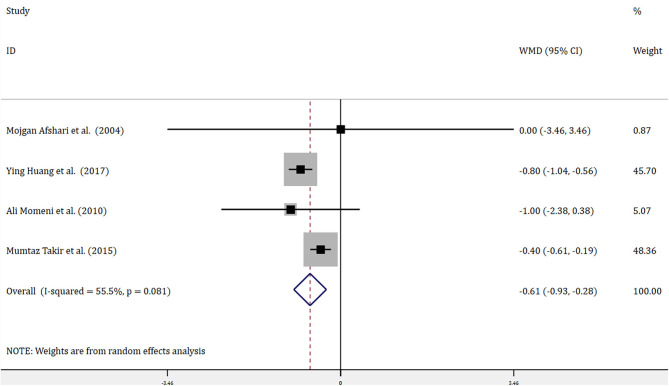
Forest plot of meta-analysis of the effect of ULT with allopurinol on FBG. Data are pooled WMDs with 95% CIs. ULT, uric acid-lowering therapy; FBG, fasting blood glucose; WMD, weighted mean difference; CIs, confidence intervals.